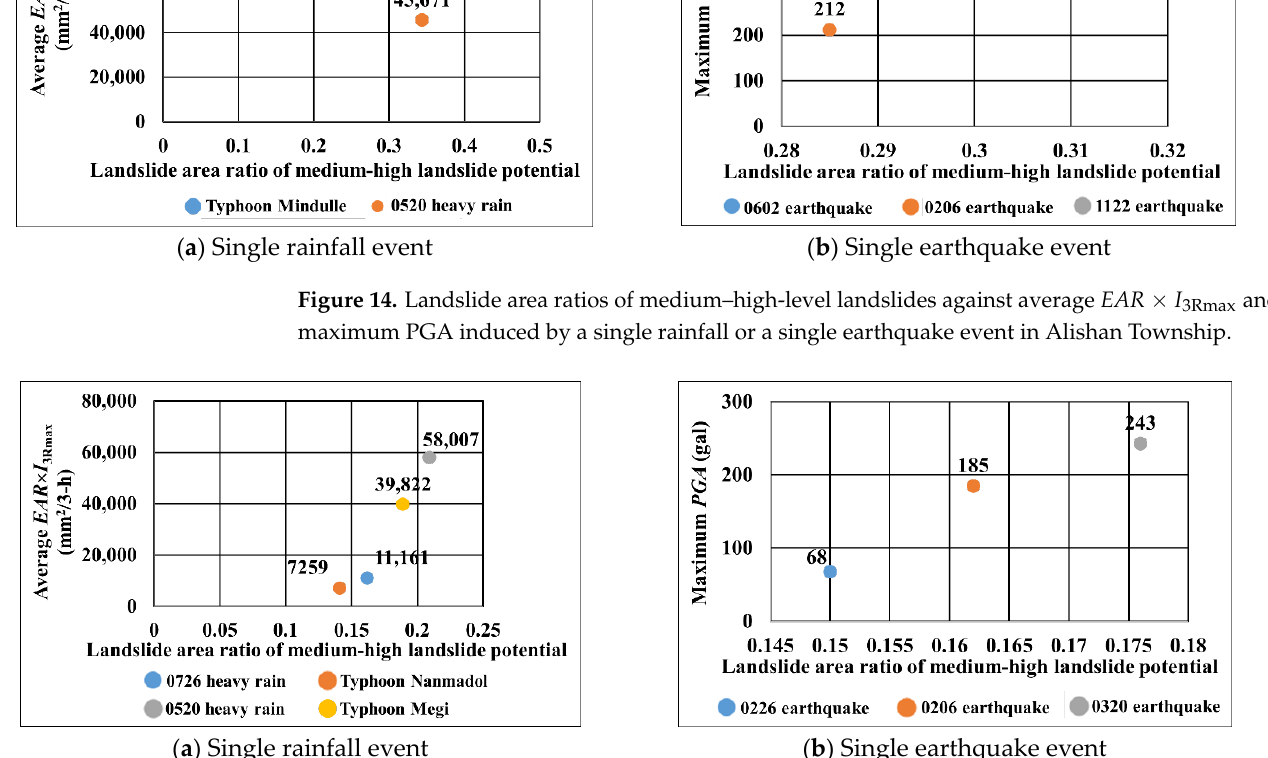
Figure 15. Landslide area ratios of medium – high-level landslides against average EAR I 3Rmax and maximum PGA induced by a single rainfall or a single earthquake event in Dapu Township.